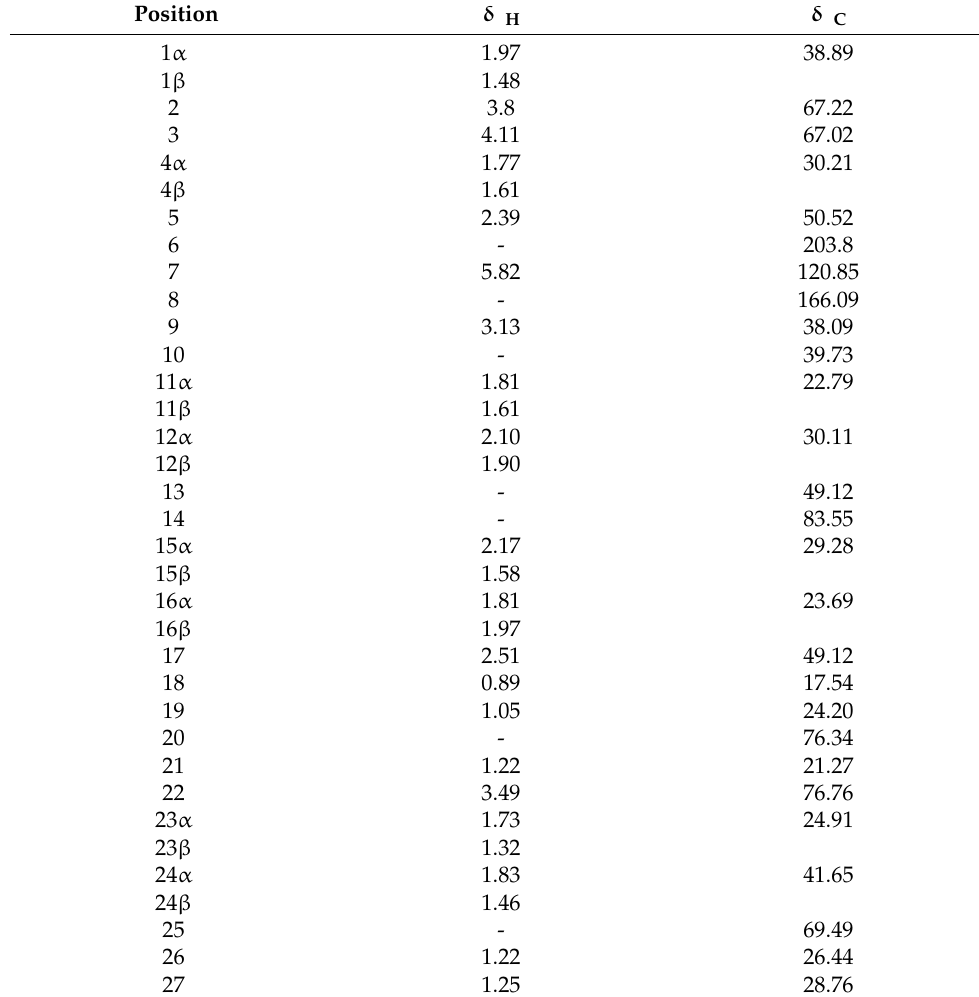
Table 1. 1 H- and 13 C-NMR assignment of